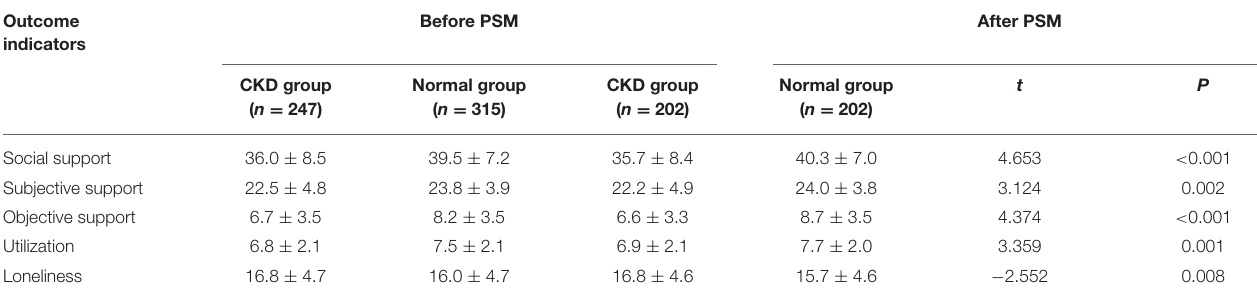
TABLE 2 | Comparison of social support and loneliness scores between observation group and control group before and after PSM. Outcome indicators